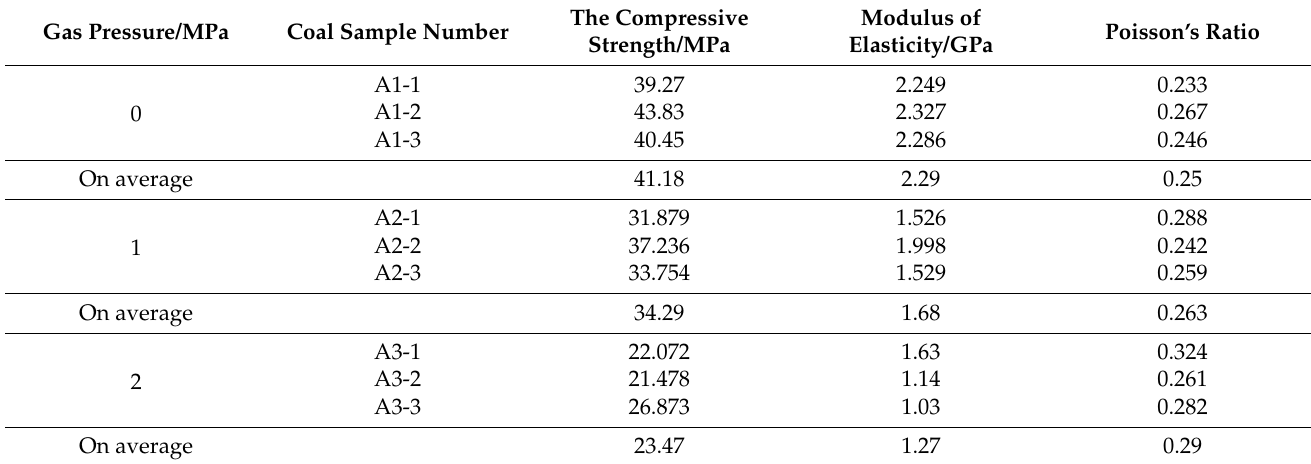
Table 2. Test results of mechanical properties of coal samples under different gas